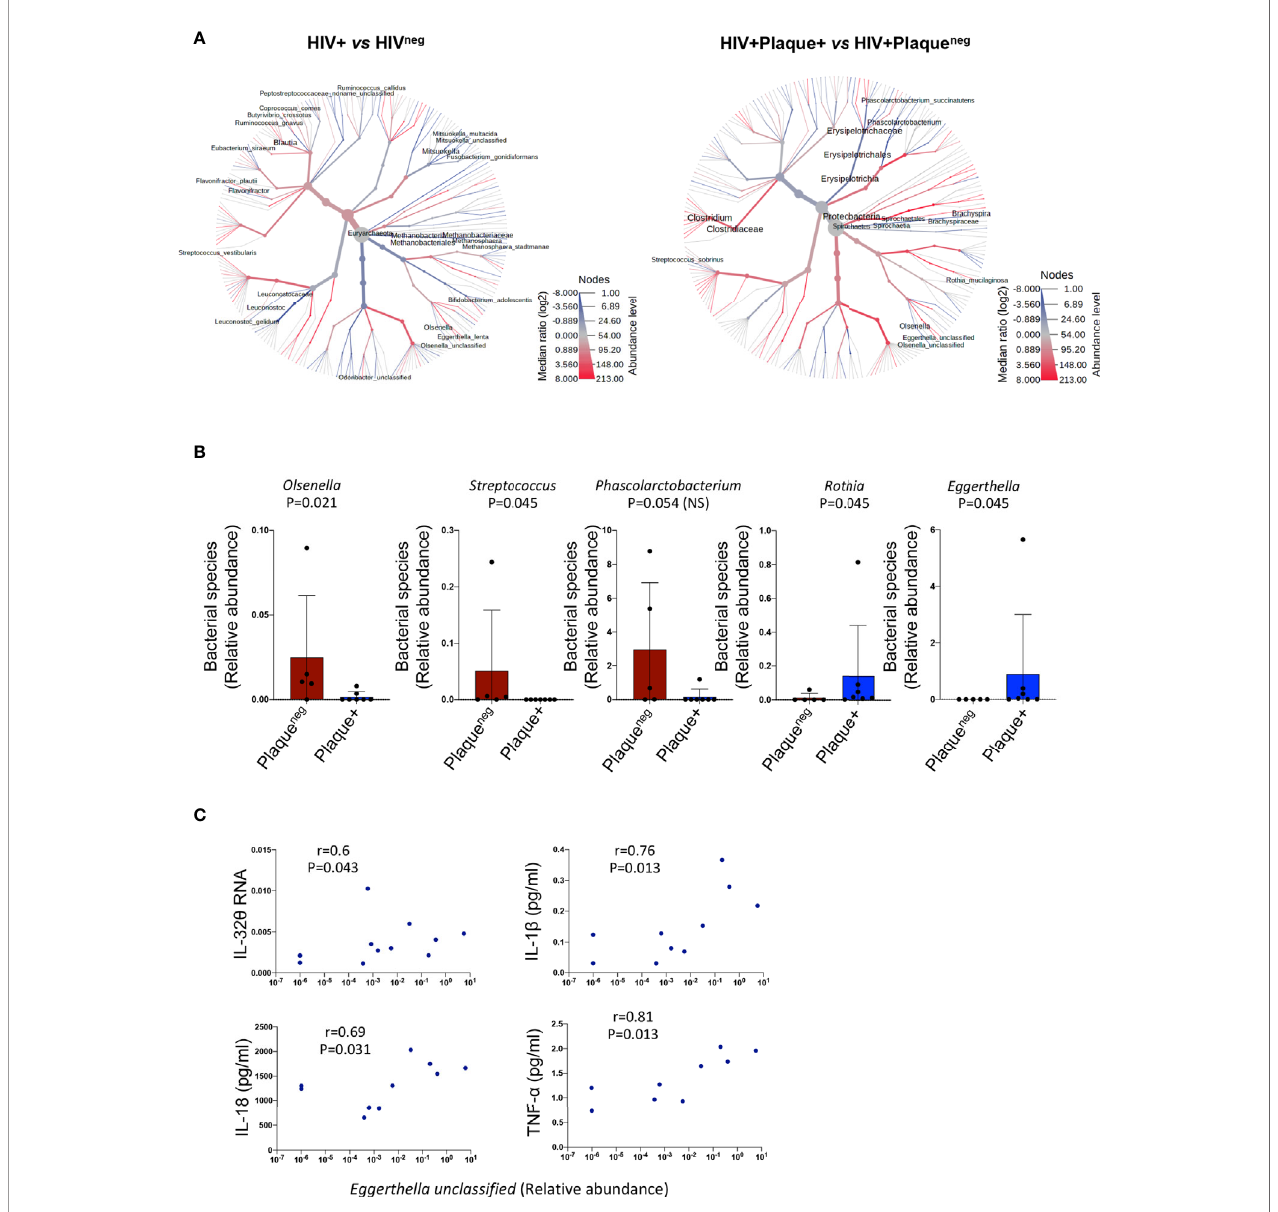
FIGURE 5 | Difference in microbiome composition in HIV+ participants with or without subclinical atherosclerosis. (A) Heat tree analysis showing group-wise relative abundance for microbial communities using the hierarchical structure of metaphlan2 taxonomic classi fi cations in HIV+ (n=12) compared to HIV neg participants (n=4) (left panel) and HIV+ with (n=7) compared to HIV+ participants without subclinical atherosclerosis (n=5) (right panel). (B) Bar graphs showing mean ± standard deviation for the signi fi cantly decreased bacterial species (left panels) and the signi fi cantly abundant species (right panels) in HIV+ participants with (n=7) compared to their counterparts without subclinical atherosclerosis (n=5). (C) Correlations between the bacterial species Eggerthella and IL-32 q , IL-1 b , IL-18 and TNF- a in the HIV+ group (with and without subclinical atherosclerosis). Non-parametric Mann-Whitney test was used to compare metaphlan2 inferred genera between Plaque neg and Plaque+ groups in (B) and non-parametric Spearman was used to test correlations in (C)